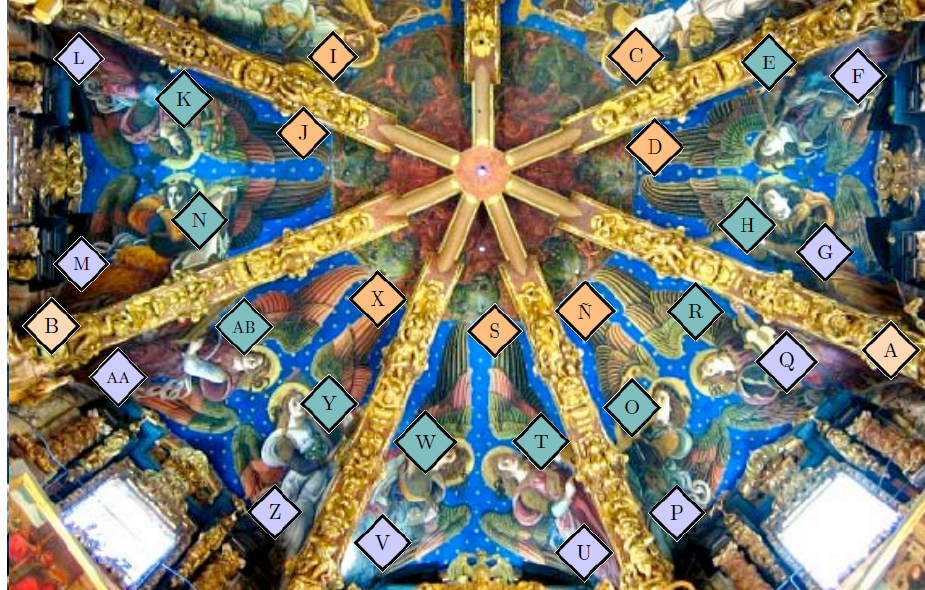
Figure 1. Approximate location of the probes and sensors at the apse vault of the cathedral of Valencia. Details of the installation of the probes and a scheme depicting the installation of probes in the frescoes can be seen in [1] and [2]. The image shows the position of the 29 probes for monitoring the relative humidity (RH) of the indoor atmosphere, displayed in different colors according to their position. Seven probes were located on the ribs (orange), two at the cornice (light orange), ten on the walls below the severies (purple), and ten probes on the frescoes